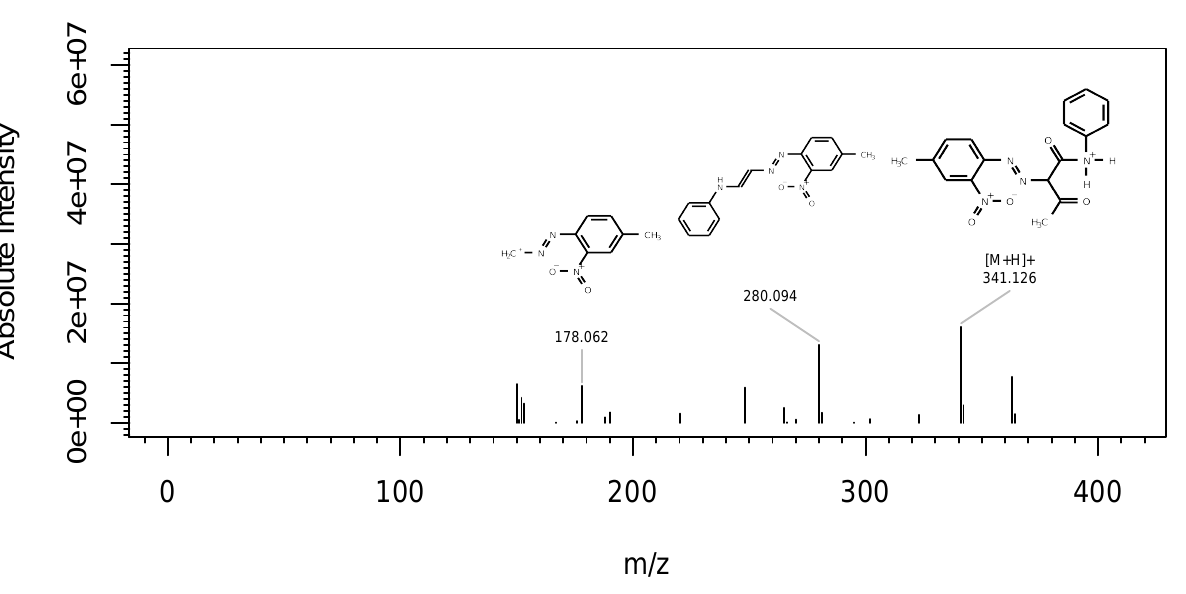
Figure A9. Challenge 12: annotated merged MS and MS/MS spectra of “Pigment Yellow 1” (APCI, positive mode).